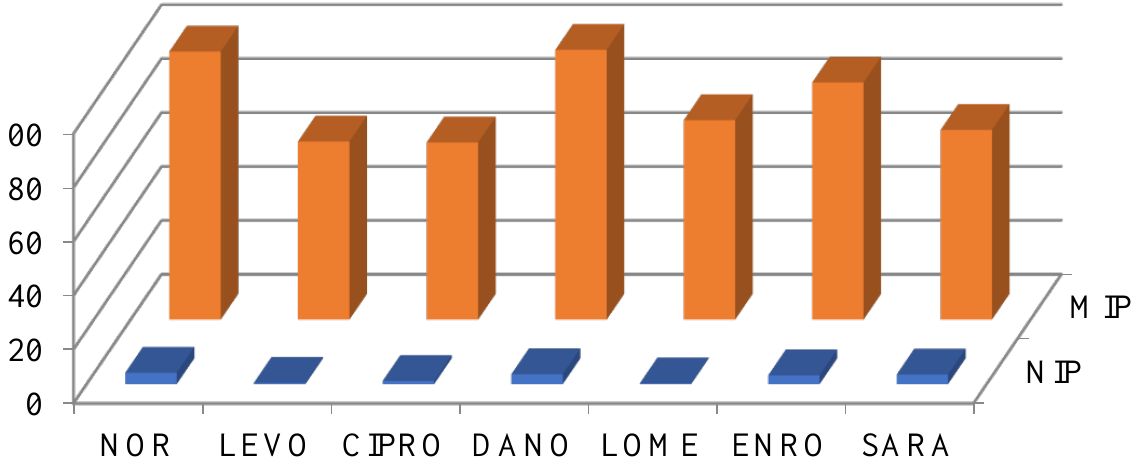
Figure 3. Recovery of target FQs in the MIP and NIP. FQs concentration: 500 ng L − 1 . Loading volume: 20 mL of water.